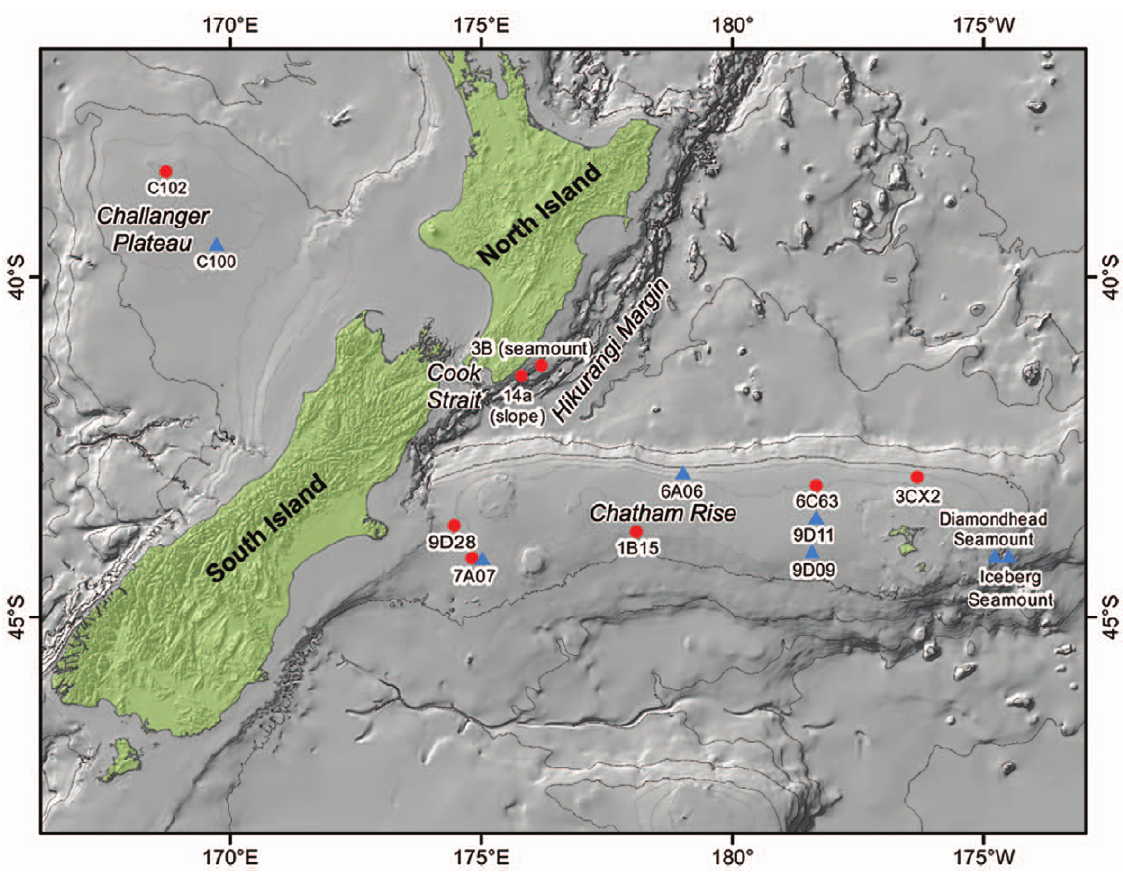
Figure 1. The location of the study area, including the North and South Islands of New Zealand (landmasses are in green), the Challenger Plateau, Hikurangi Margin, and Chatham Rise. Red circles mark sites from which Munida gracilis were collected; blue triangles mark sites from which Hyalinoecia longibranchiata were collected. Sites are labeled with their original site names. Samples were selected within a depth band of 400–800 m with Munida gracilis between 421 m and 634 m, and Hyalinoecia longibranchiata between 478 m to 746 m. The depth of each site is listed in Table 1.